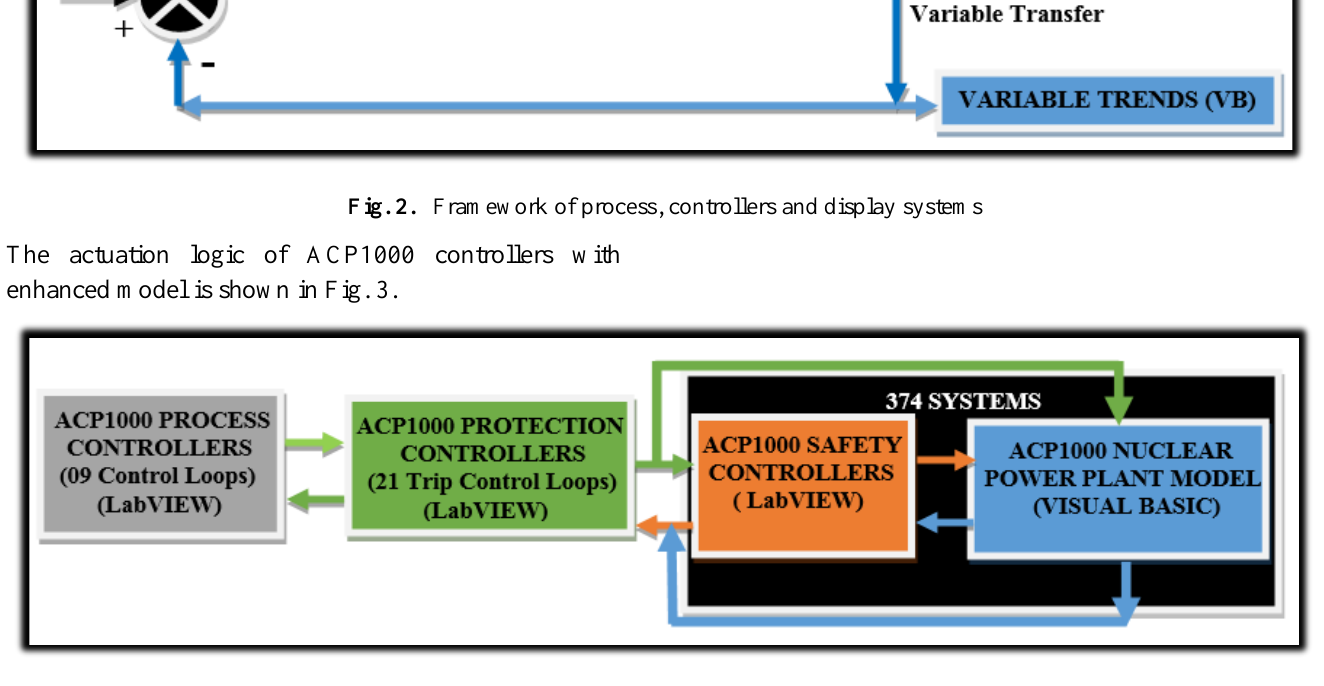
Fig. 3. Actuation logic of ACP1000